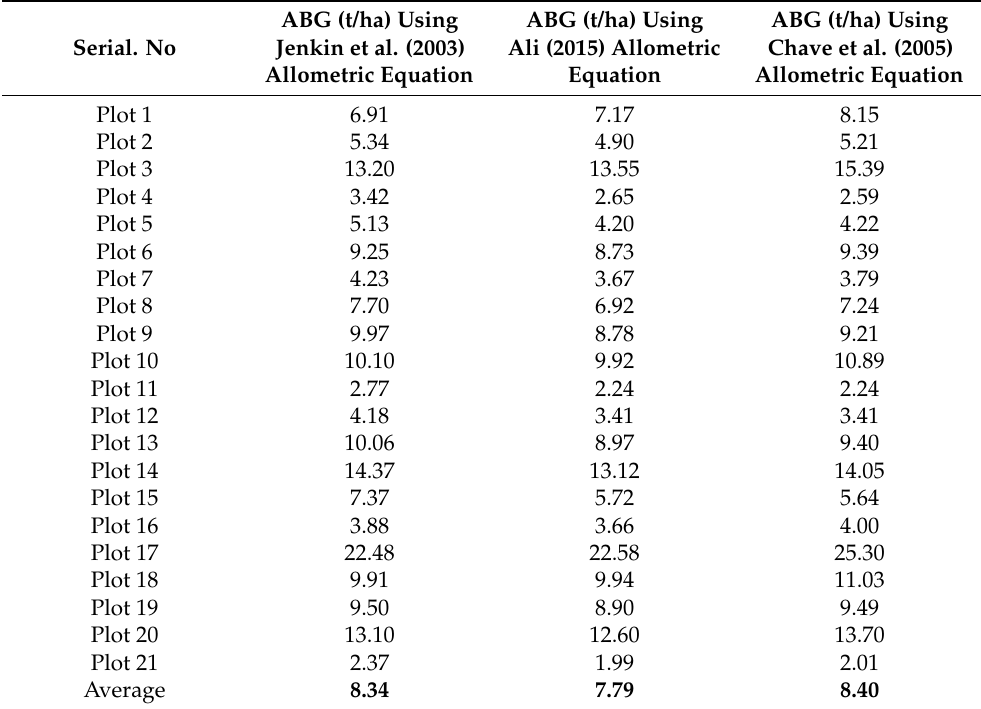
Table 6. Comparison of the above ground carbon using the allometric equations from Jenkin et al. [15], Ali [32], and Chave et al.